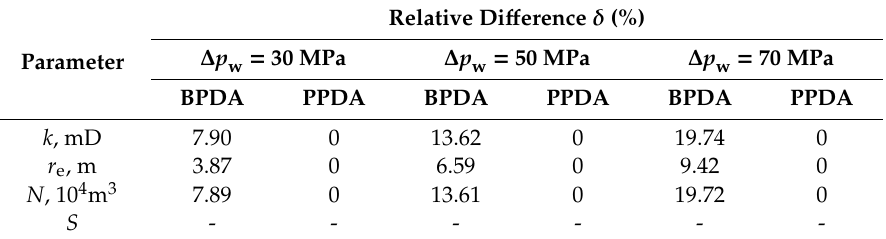
Table 5. Relative di ff erences between the actual values and estimated values for CPP cases.